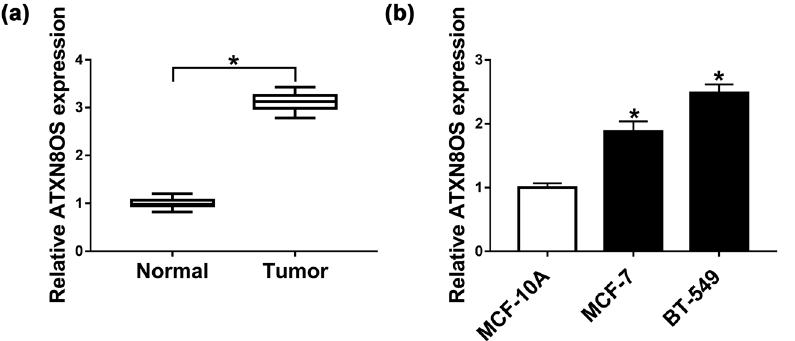
Figure 1.: ATXN8OS was highly expressed in BC tissues and cells. ATXN8OS expression by qRT - PCR in 22 pairs of BC tissues and adjacent normal breast tissues ( a ) and MCF - 10A, MCF - 7, and BT - 549 cells ( b ) . * P <